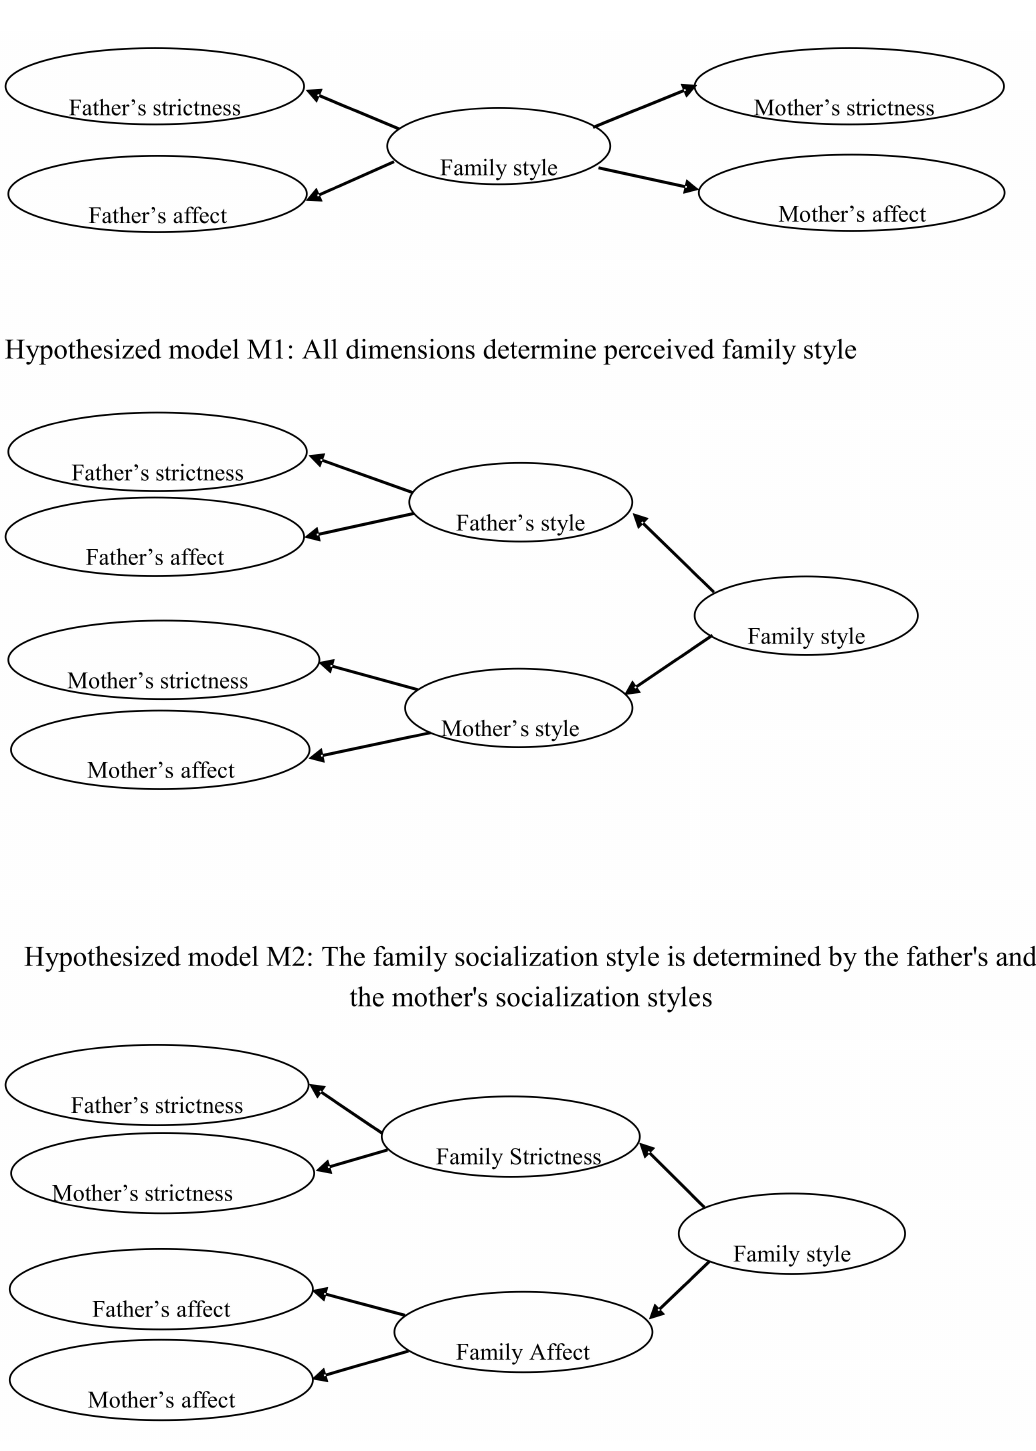
Figure 1. Hypothesized theoretical